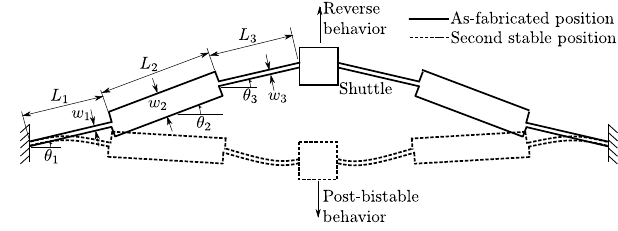
Figure 1. A classic fully-compliant bistable mechanism.